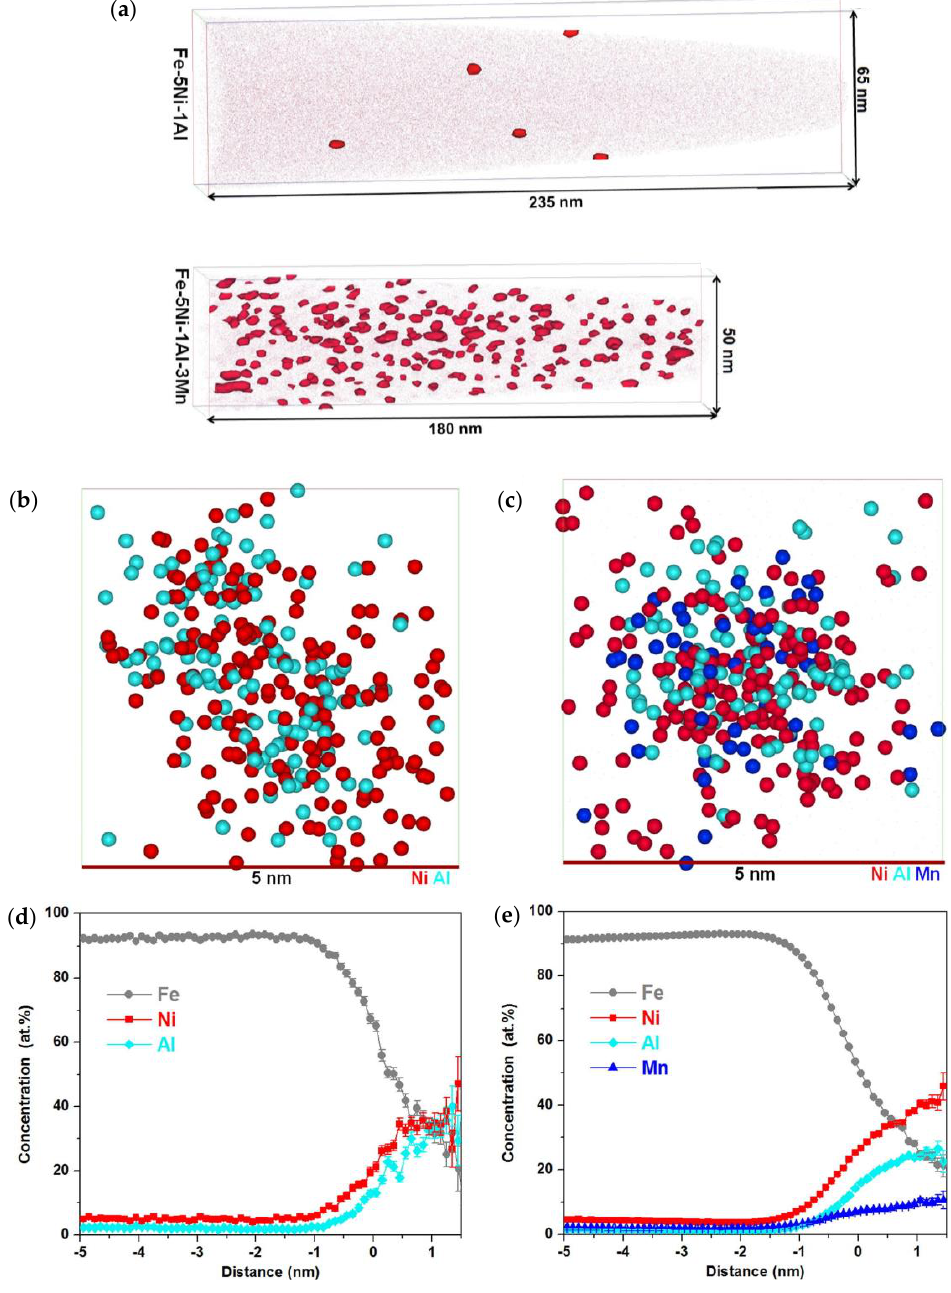
Figure 9. Atom probe tomography (APT) analysis showing ( a ) three-dimensional (3D) reconstruction; ( b , c ) atoms map; ( d , e ) proximity histogram of NiAl precipitates in Fe-5Ni-1Al and Fe-5Ni-1Al-3Mn, respectively. Mn enters the NiAl nuclei, resulting in high number density of nano-scale NiAl precipitates [2].